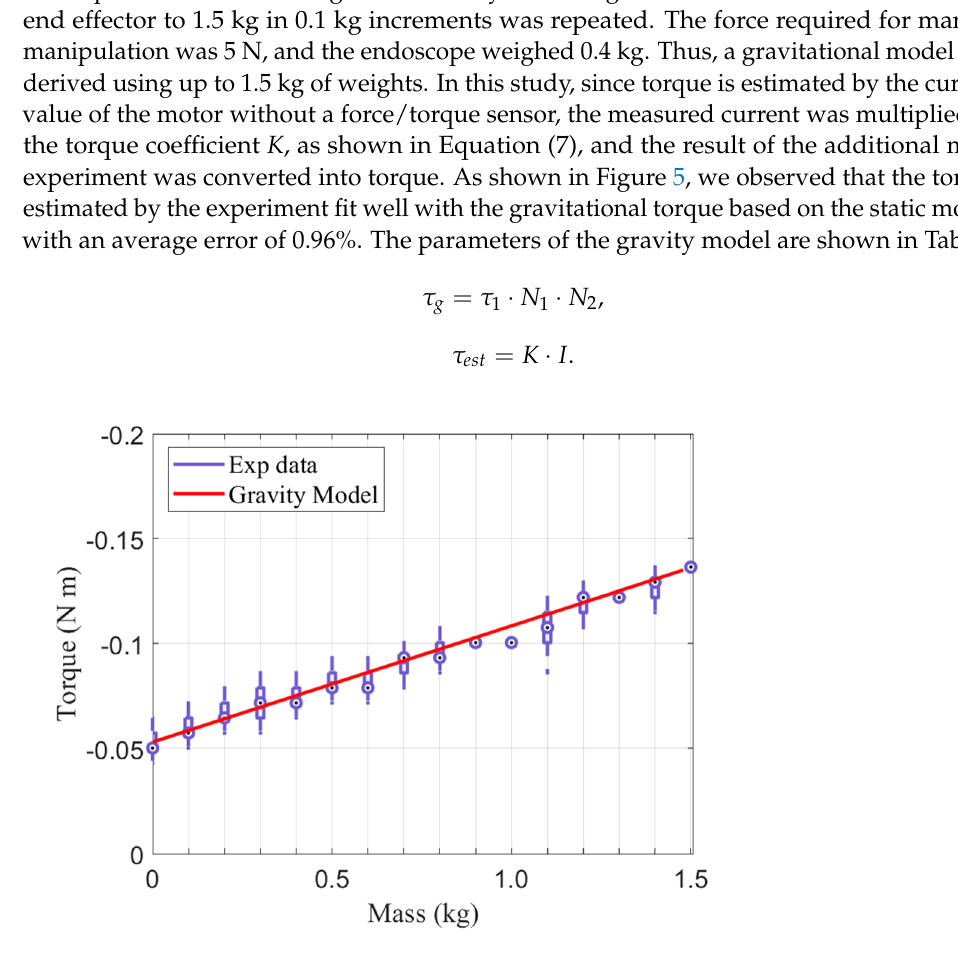
Table 2. Parameters for the gravity model.